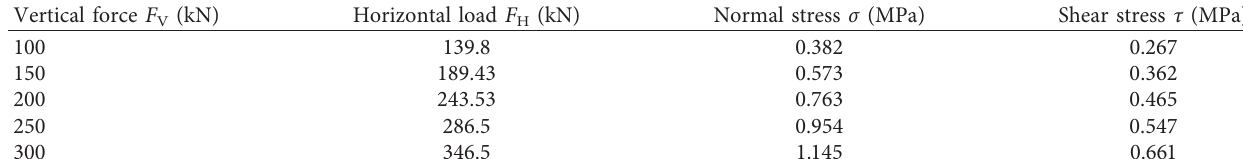
Table 4: Ultimate load and the corresponding value of stress.